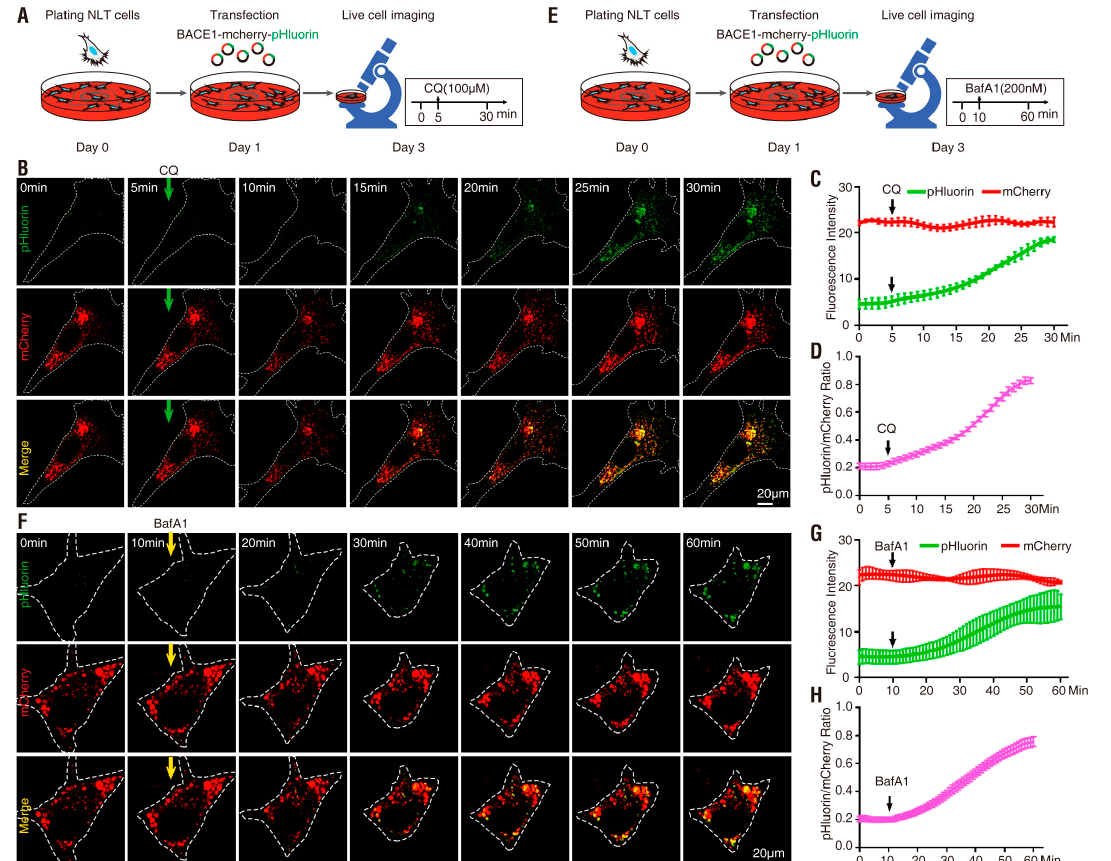
Figure 2. Response of NLT cells expressing BACE1 ‐ mCherry ‐ pHluorin to chloroquine (CQ) and bafilomycin A1(BafA1) treatment ( A ) Schematics of live cell imaging experimental procedures. NLT cells were plated on Day 0 and co ‐ transfected with BACE1 ‐ mCherry ‐ pHluorin and blue fluorescent protein (BFP) on Day 1. NLT cells expressing BACE1 ‐ mCherry ‐ pHluorin were imaged every minute for 30 min on Day 3 and treated with 100 µM CQ after 5 min. ( B ) Representative images from live cell imaging in response to CQ. NLT cells expressing BACE1 ‐ mCherry ‐ pHluorin (red and green) were outlined according to BFP expression. Scale bar, 20 µm. ( C ) The fluorescence signal intensity of mCherry (red) and pHluorin (green) in the outlined area was measured using ImageJ and plotted over time in response to CQ. Data were shown as mean ± SEM ( n > 15 cells from three independent experiments). ( D ) Quantification analysis of the pHluorin/mCherry ratio from C. Data was shown as mean ± SEM ( n > 15 cells from three independent experiments). ( E ) Schematics of live cell imaging experimental procedures. NLT cells were plated on Day 0 and co ‐ transfected with BACE1 ‐ mCherry ‐ pHluorin and BFP on Day 1. NLT cells expressing BACE1 ‐ mCherry ‐ pHluorin were imaged every minute for 60 min on Day 3 and treated with 200 nM BafA1 after 10 min. ( F ) Representative images from live cell imaging in response to BafA1. NLT cells expressing BACE1 ‐ mCherry ‐ pHluorin (red and green) were outlined according to BFP expression. Scale bar, 20 µm. ( G ) The fluorescence signal intensity of mCherry (red) and pHluorin (green) in the outlined area were measured and plotted over time in response to BafA1. Data were shown as mean ± SEM ( n > 15 cells from three independent experiments). ( H ) Quantification analysis of the pHluorin/mCherry ratio from G. Data was shown as mean ± SEM ( n > 15 cells from three independent experiments).